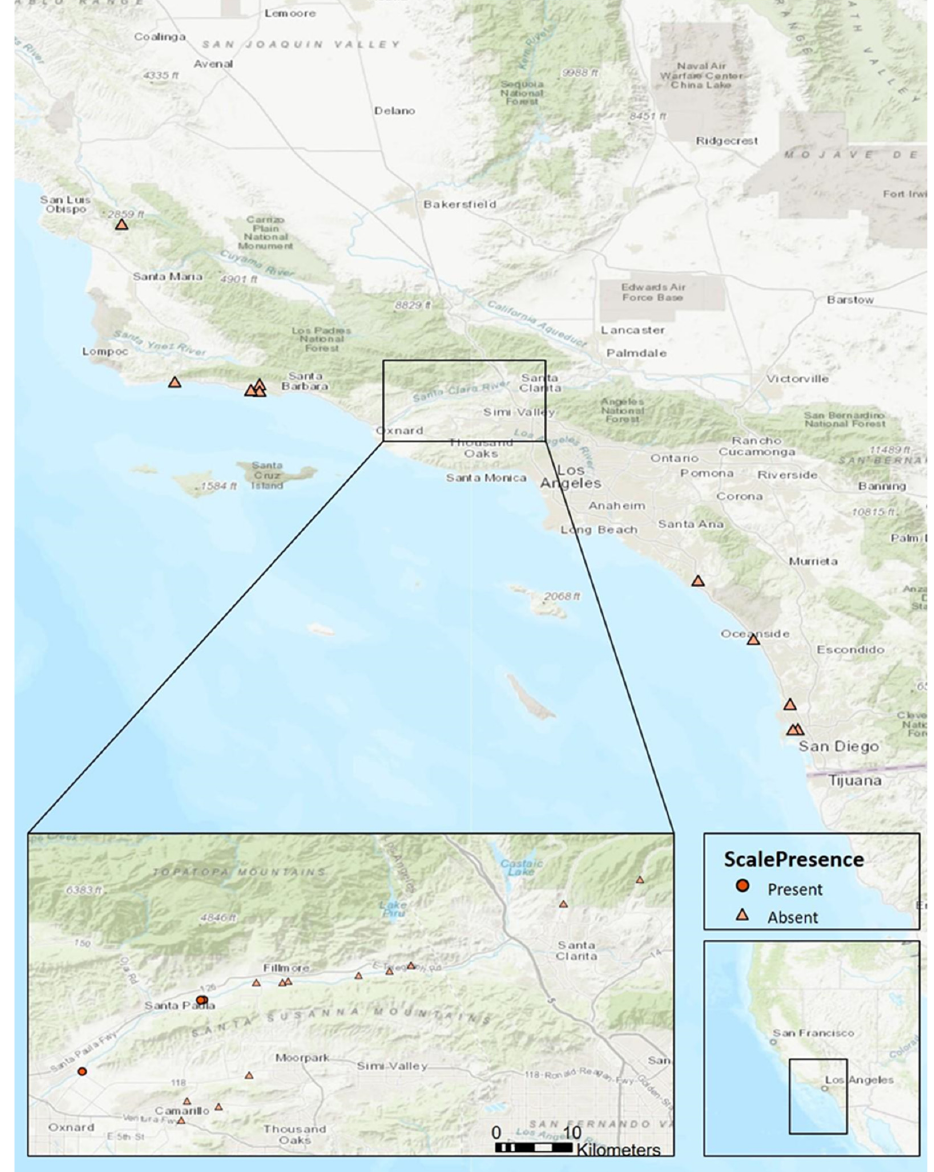
Figure 3. Distribution of Rhizaspidiotus donacis throughout central and southern California. Surveys were conducted in 2018–2020. Trials conducted with adventive scales were performed with individ- uals collected from the population near Santa